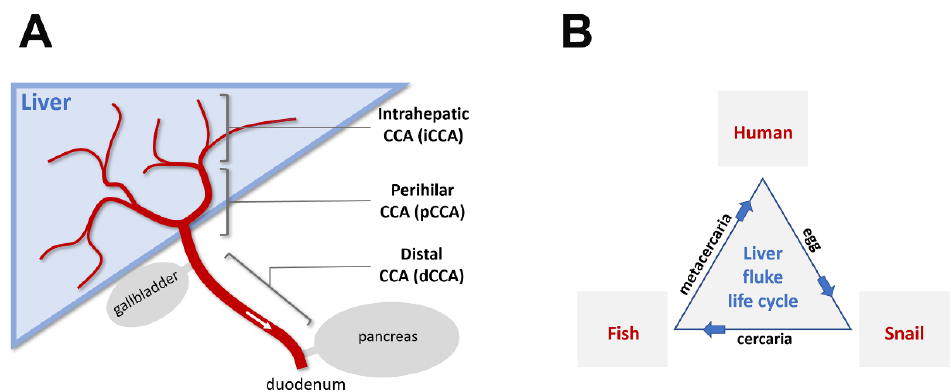
Figure 1. Schematic diagram of cholangiocarcinoma (CCA) types and the liver fluke life cycle. ( A ): The bile duct and its relationship to the liver, gallbladder, pancreas, and duodenum. The biliary tree (red) is composed of the ampulla of Vater (opening to the duodenum part of the small intestine after joining of the pancreatic duct), common bile duct (after joining of the cystic duct from gallbladder, before joining of the pancreatic duct), common hepatic duct (after joining of the left and right hepatic ducts, before joining of the cystic duct), left and right hepatic ducts, and progressively narrower intrahepatic ducts and ductules. CCAs are categorized based on the origin of tumorigenic cholangiocytes within the biliary tree. Fluke-induced CCAs are primarily of the intrahepatic type, likely due to comparable lumen diameters with respect to the size of adult parasitic flukes. ( B ): Life cycle of liver flukes in humans. Parasitic liver flukes ( Opisthorchis viverrini and Clonorchis sinensis ) use the human bile duct as a host environment for sexual maturation. Eggs generated from cross- fertilization of hermaphroditic adult liver flukes pass through feces and infect the first intermediate host (snails) after a brief period of free-living development. Asexual reproduction takes place in this host environment. Larval flukes (cercariae) released from infected snails metamorphose into encysted metacercariae either in a natural environment or in a second intermediate host (freshwater fish for liver flukes in humans). The encystment in fish muscular tissues presumably confers evolutionary advantage for liver flukes in reaching their final parasitic host environment, where they can live for up to two decades.